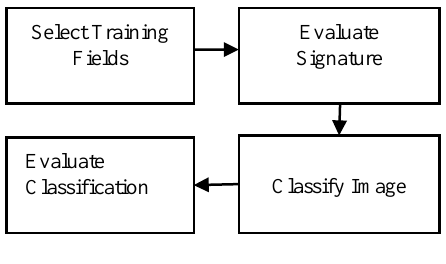
Fig:1 Working of Supervised